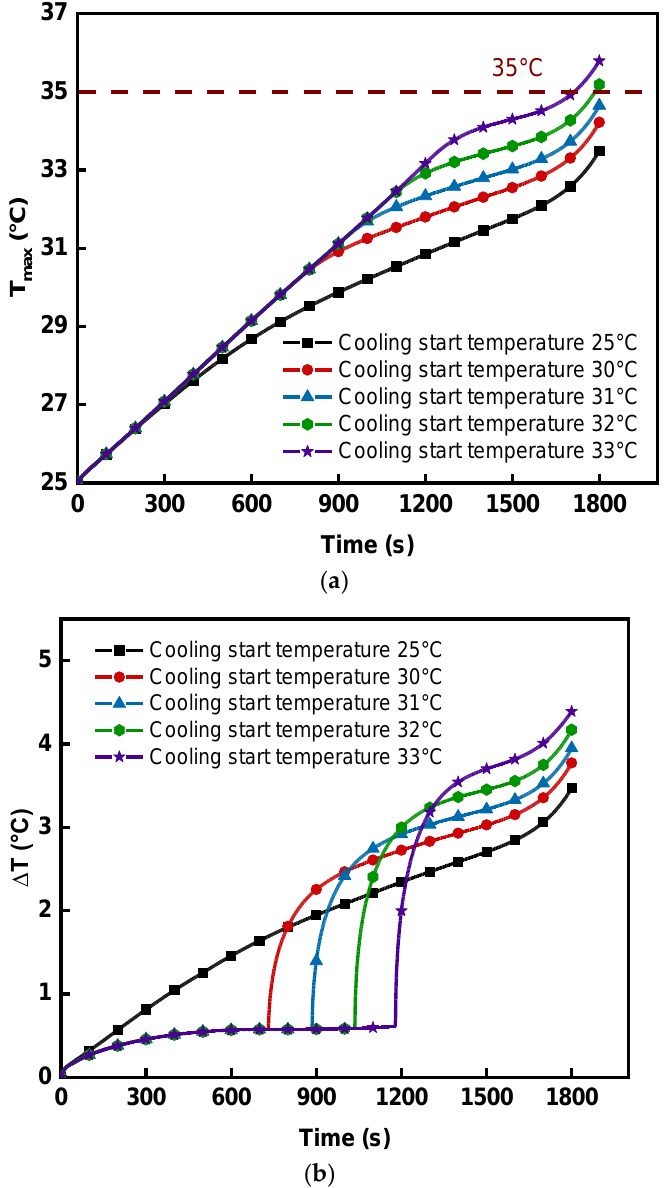
Figure 9. Effect of cooling start temperature CST on: ( a ) maximum temperature T max ; ( b ) maximum temperature difference D T of battery module.